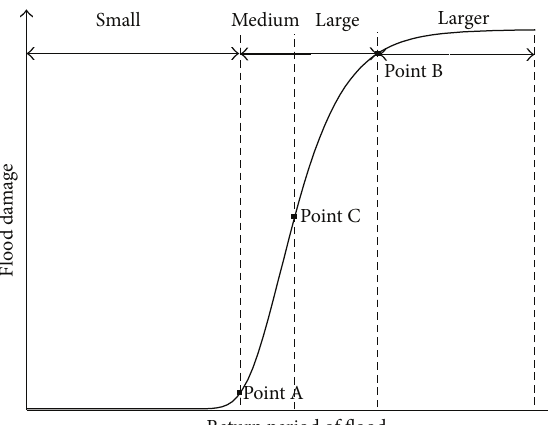
Figure 4: Flood 𝑅 - 𝐷 function curve.